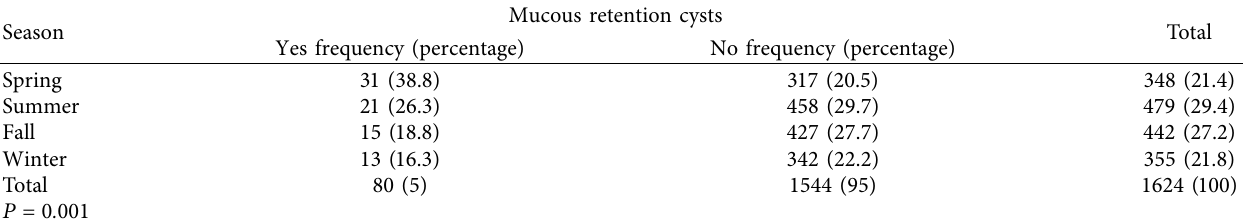
Table 7: The frequency of mucous retention cysts (MRCs) in the population was studied following the seasons of the